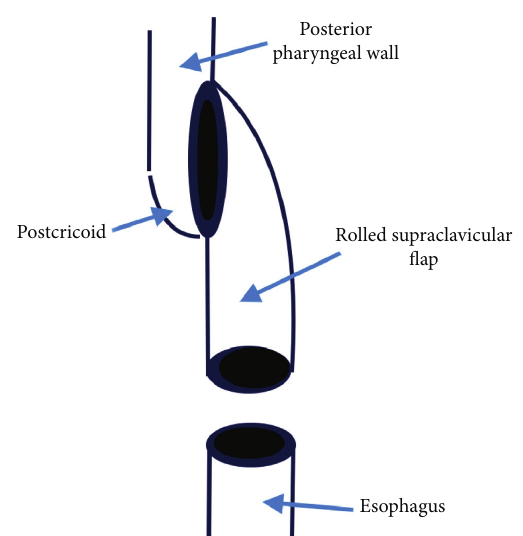
Figure 2: The rolled flap was advanced and connected (using modified Gambee suture) to pharyngeal wall to provide additional mucosa to cover the